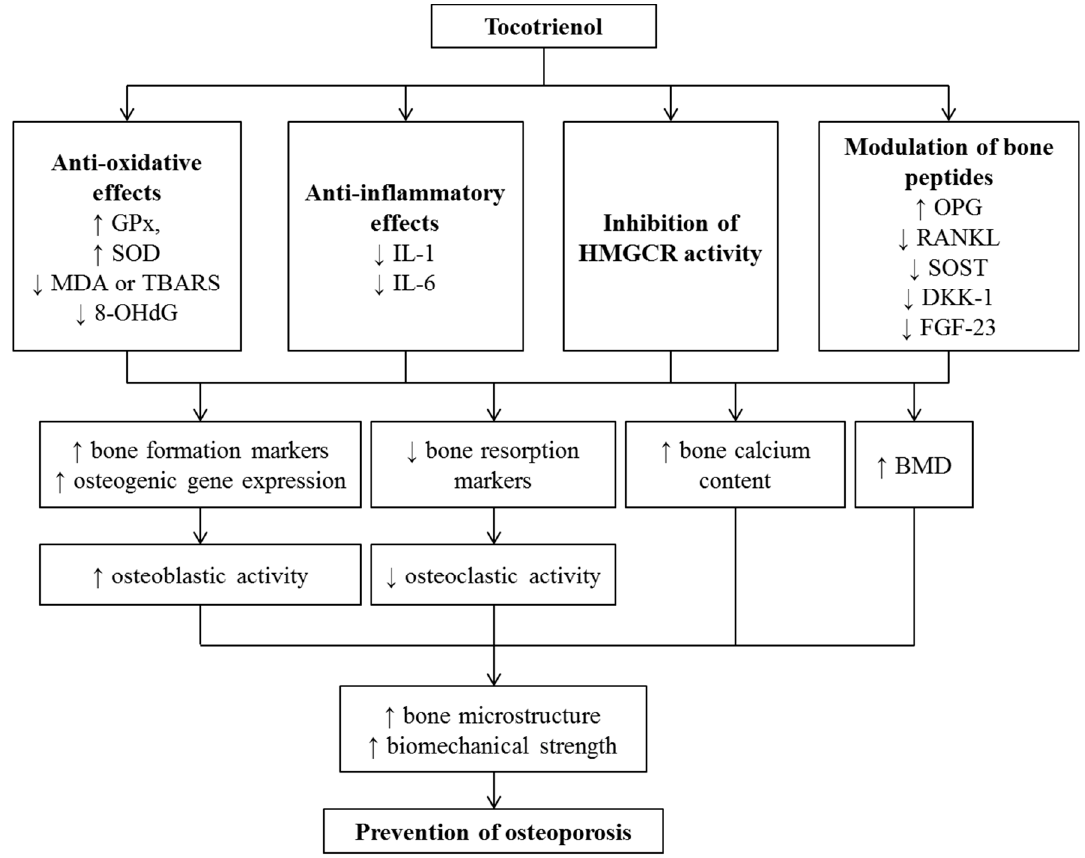
Figure 4. Bone-protecting property of T3.